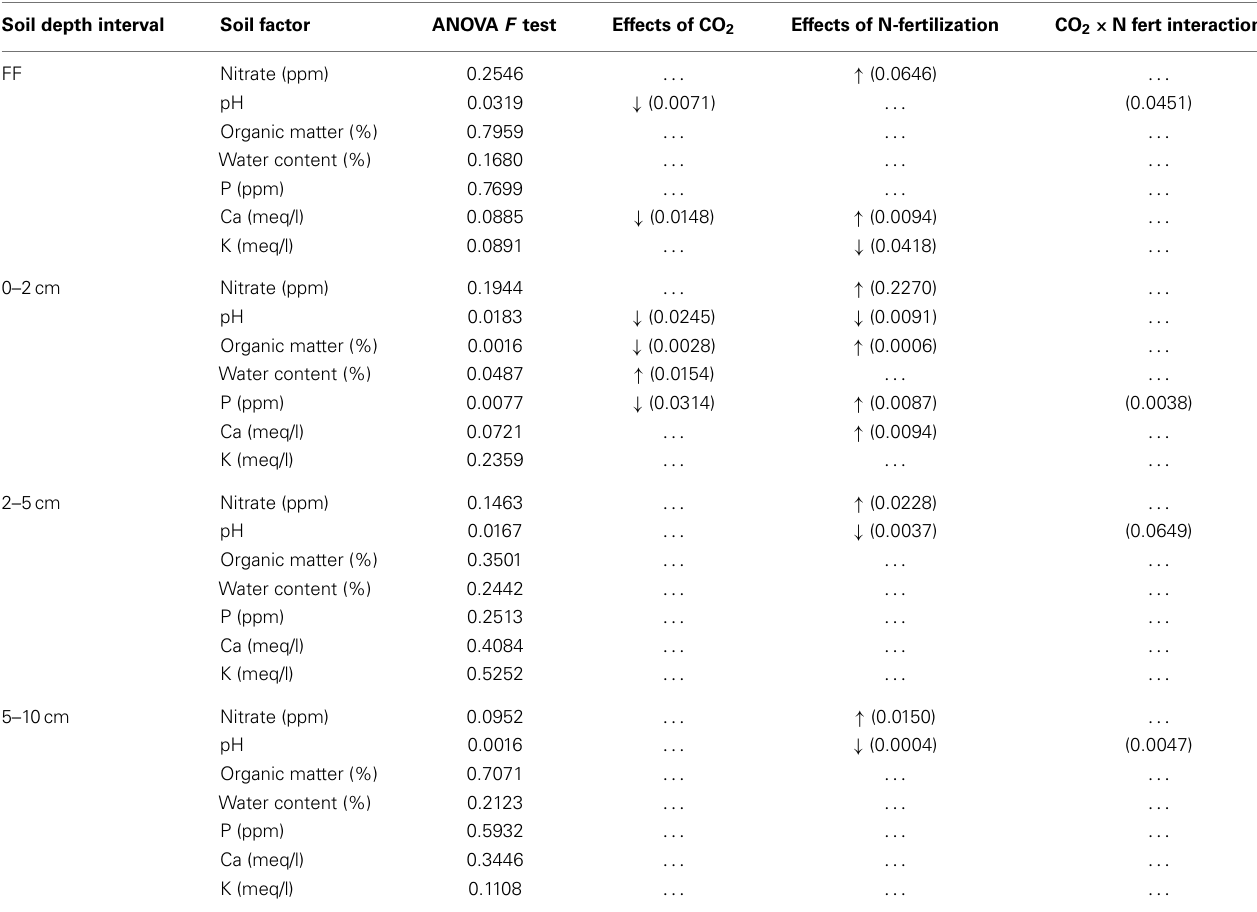
Table 2 | Changes in soil chemical and physical measures after long-term elevated atmospheric CO 2 conditions, N-fertilization or the combination of treatments, at four soil depth intervals.